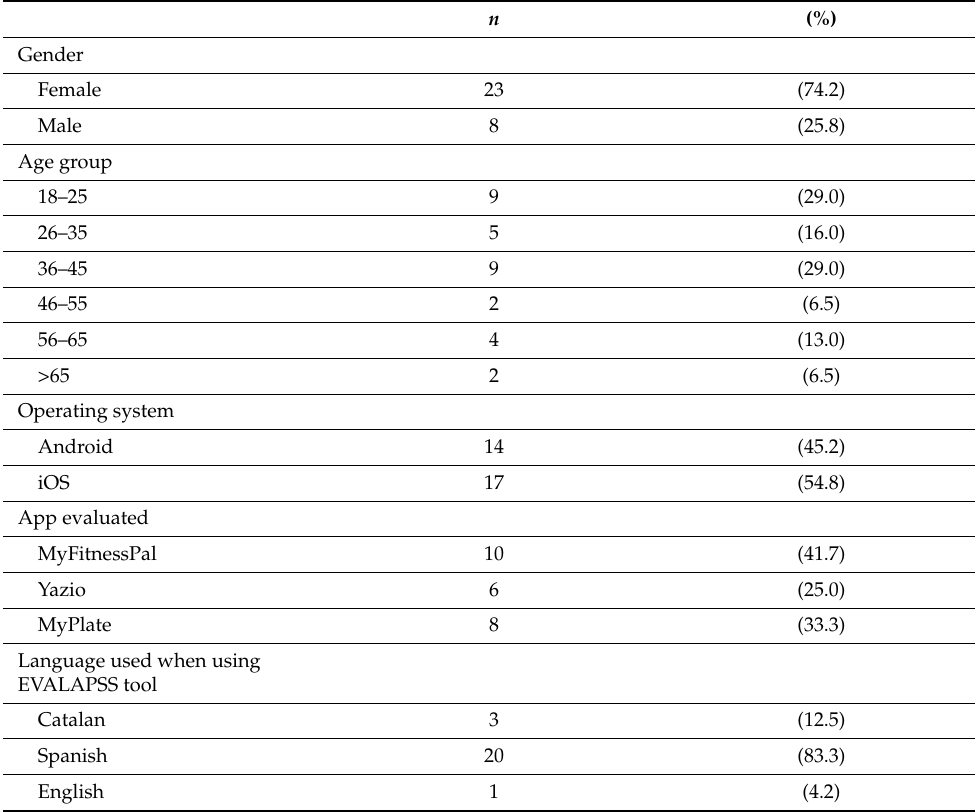
Table 2. Sociodemographic and technological characteristics of the EVALAPPS pilot testing.